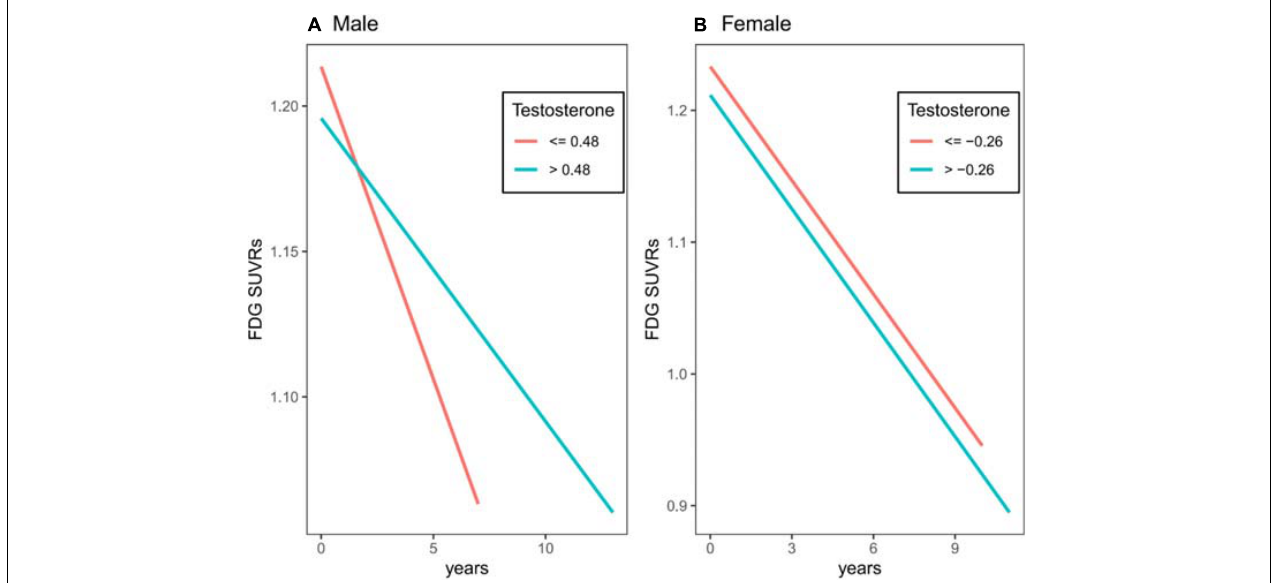
FIGURE 3 | Longitudinal association of plasma total testosterone levels with FDG SUVRs in males and females. (A) In males, higher plasma testosterone levels were significantly associated with slower decline in FDG SUVRs. (B) In females, we did not find a relationship between plasma total testosterone levels and change in FDG SUVRs over time.